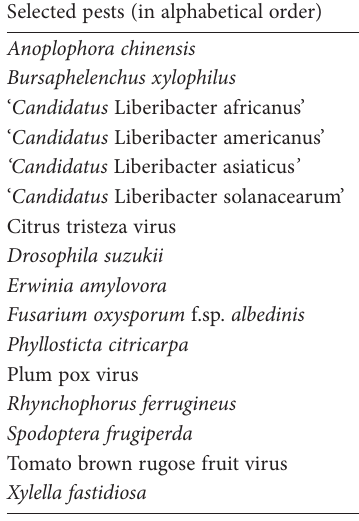
Table 1. Priority pests for the Mediterranean region, identified through a survey. Selected pests (in alphabetical